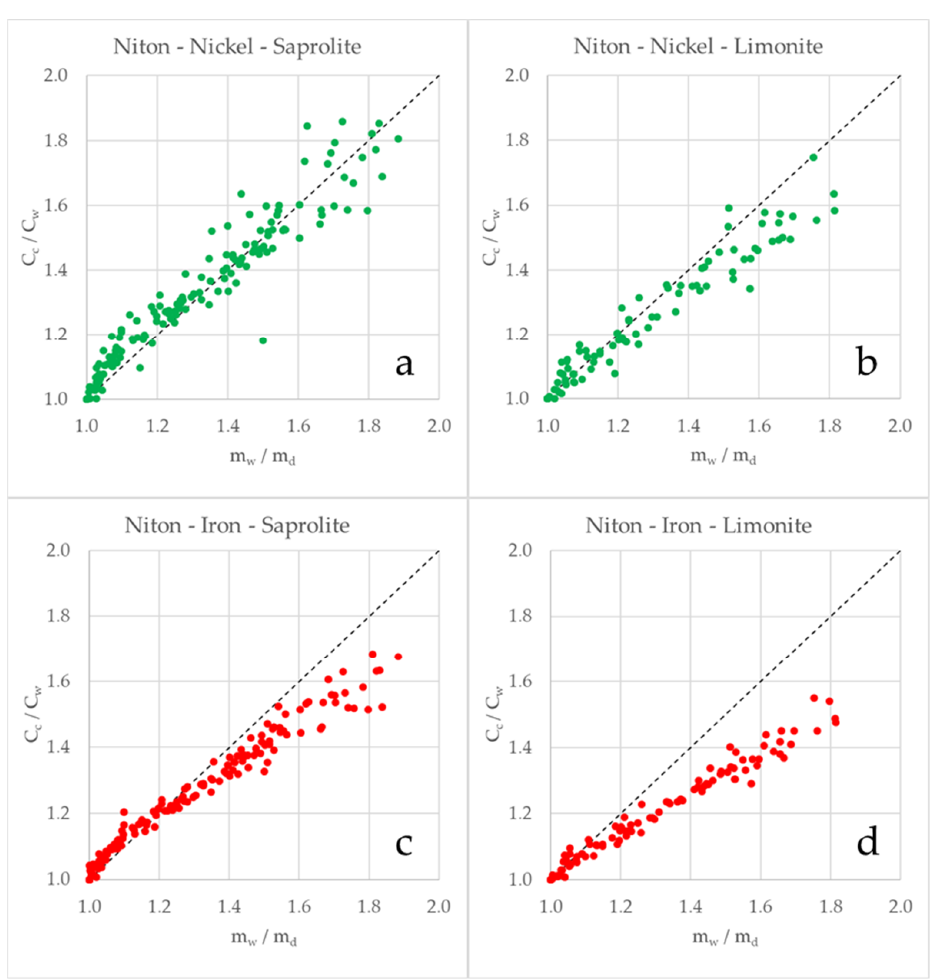
Figure 10. Data from the Niton after correction with the dilution law: ( a ) Ni in the saprolite layer; ( b ) Ni in the limonite layer; ( c ) Fein the saprolite layer; ( d ) Fe in the limonite layer.